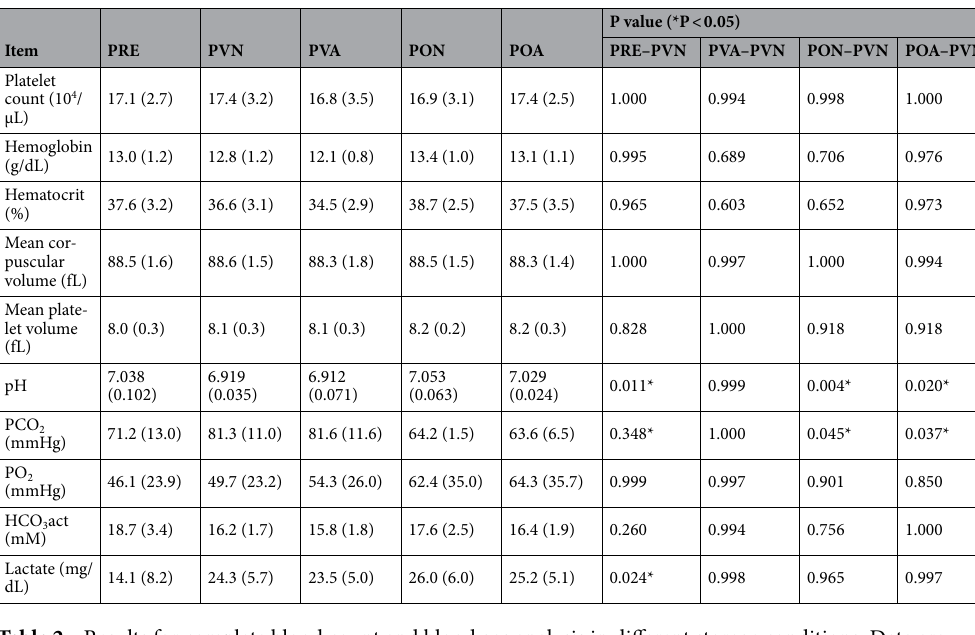
Table 2. Results for complete blood count and blood gas analysis in different storage conditions. Data are expressed as mean (SD). N = 6. *P < 0.05 vs. PVN by one-way ANOVA with a Dunnett multiple comparison test.